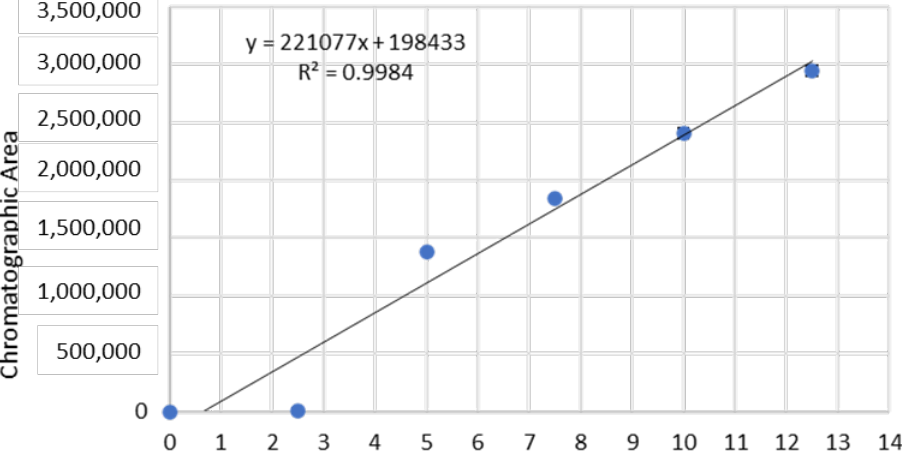
Figure 2. Calibration curve and linear regression model equation obtained for the chromatographic area of each adulterated milk with cheese whey percentage. The samples analyzed were prepared in quadruplicate for each of adulterate sample point (0%, 2.5%, 5%, 7.5%, 10%, 12.5%, 15%, and 20% (m/m)); the average and precision of data is presented for each adulteration